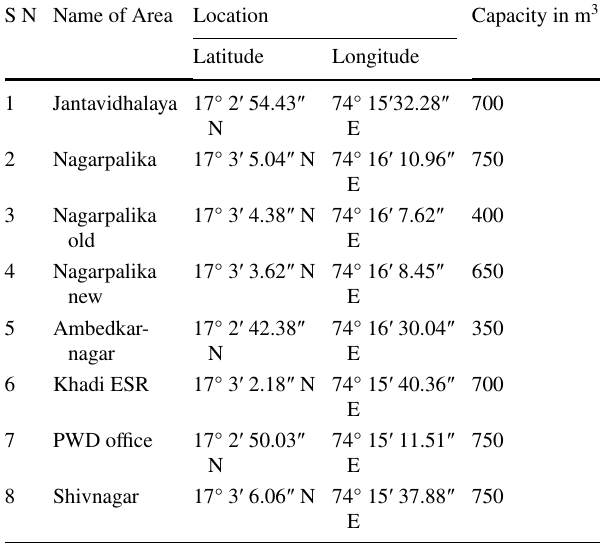
Table 1 ESR locations and their capacity